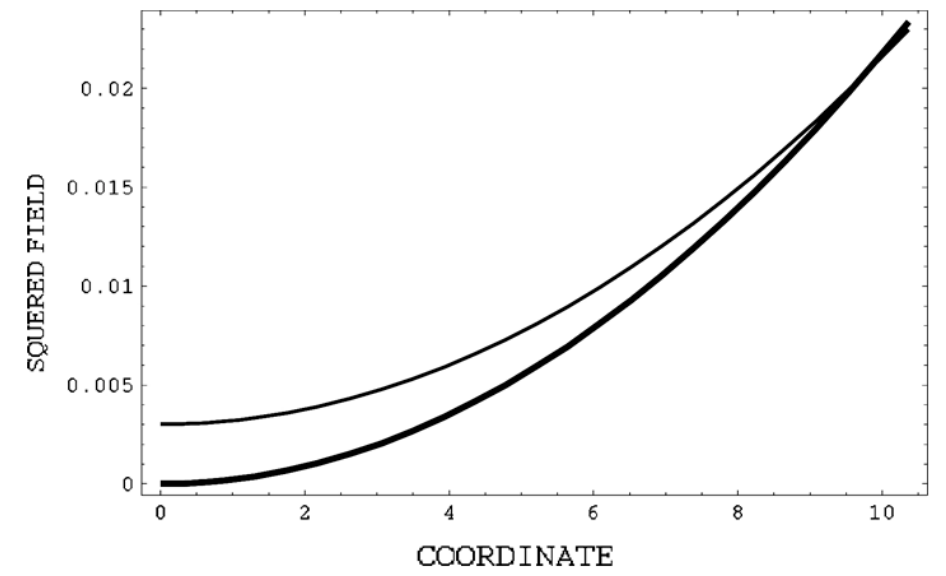
Figure 4. Calculated second order CEM energy (arbitrary units) distributions for the π - σ and σ - π polarization cases close to the CLC layer surface versus coordinate (in the dimensionless units 2 z τ ) for a plane wave directed inside (bold line) and outside the layer for the first second order edge mode ( δ 2 (cos 2 θ )/4sin θ = 0.05, N = 16.5, n = 1).